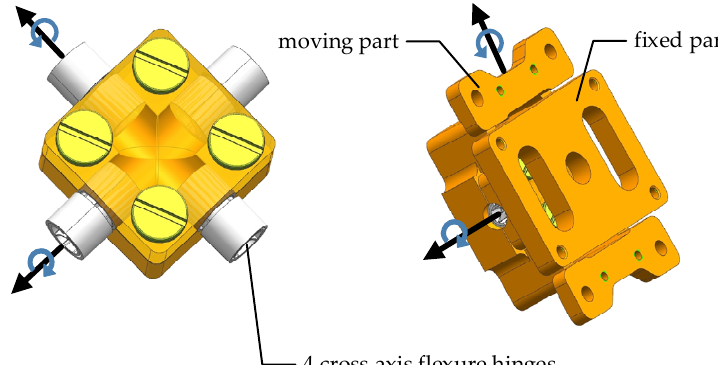
Figure 11. Flexible supporting structure.